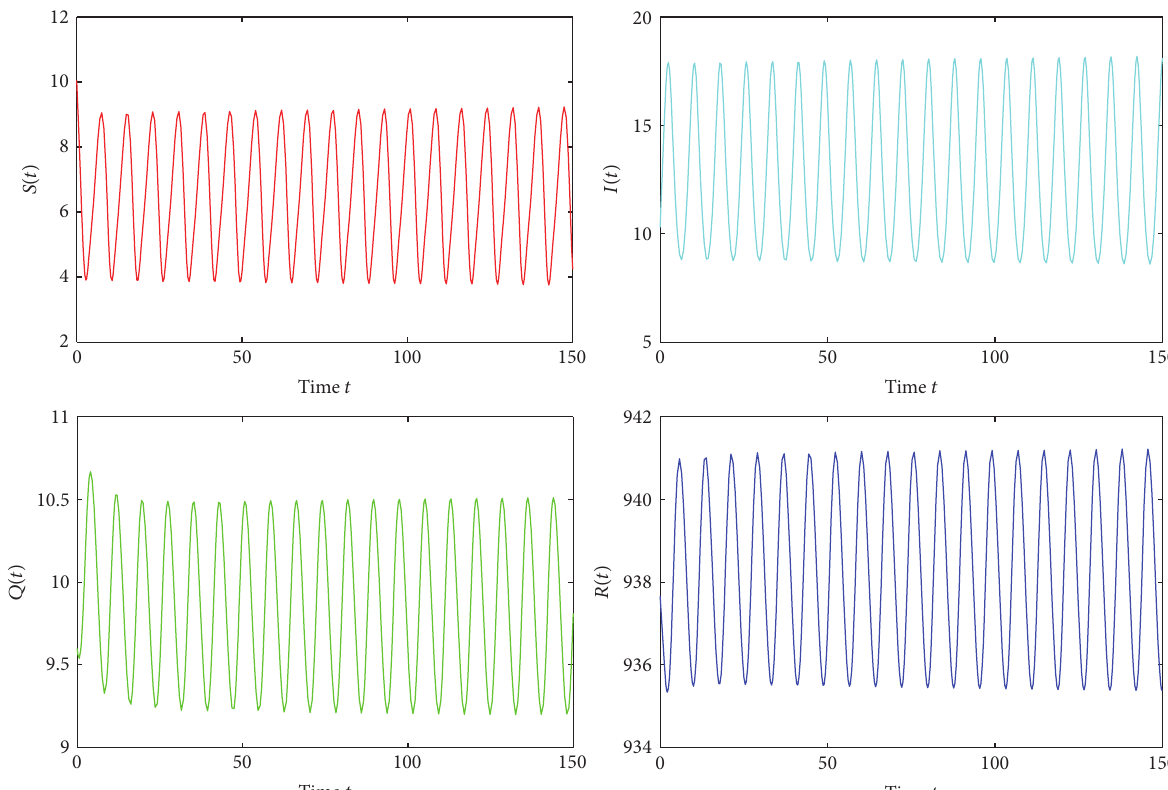
Figure 22: The trajectory of 𝑆 , 𝐼 , 𝑄 , and 𝑅 when 𝜏 2 = 1.52 > 1.3485 = 𝜏 󸀠 20 and 𝜏 1 = 0.65 .